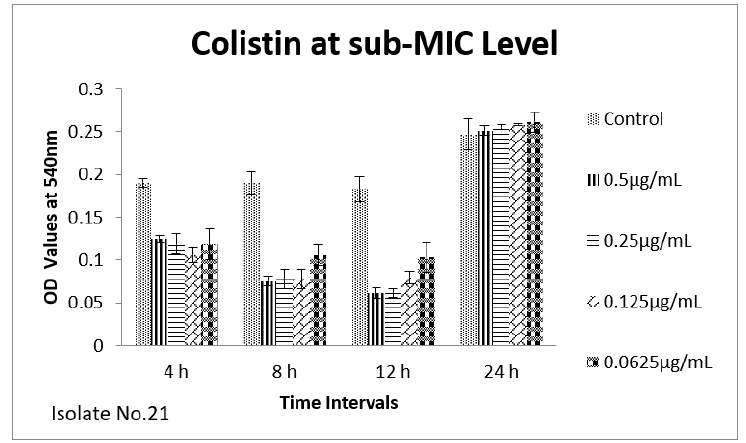
Figure 8. Shown are the effects of colistin on E. coli biofilm at different time intervals (OD 540 nm). Bar graph represents highest biofilm formation after 24 h of incubation.